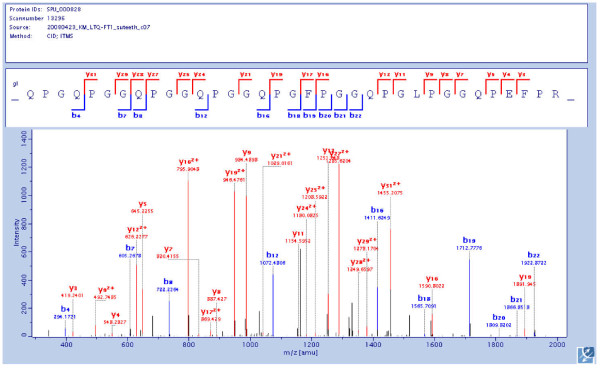
MS/MS spectrum of a SM30-D peptide. This spectrum shows the MS/MS analysis of a triply charged peptide confirming the annotated predicted sequence contained in SPU:000828. As to be expected almost all of the major y-ions correspond to preferential cleavages N-terminal to prolines. The N-terminal Gln is cyclized to pyroglutamine. The mass error was 0.11 ppm, the PEP score was 3.01E-46 and the Mascot score was 63. Spectra of other unique peptides are shown in additional file 6.